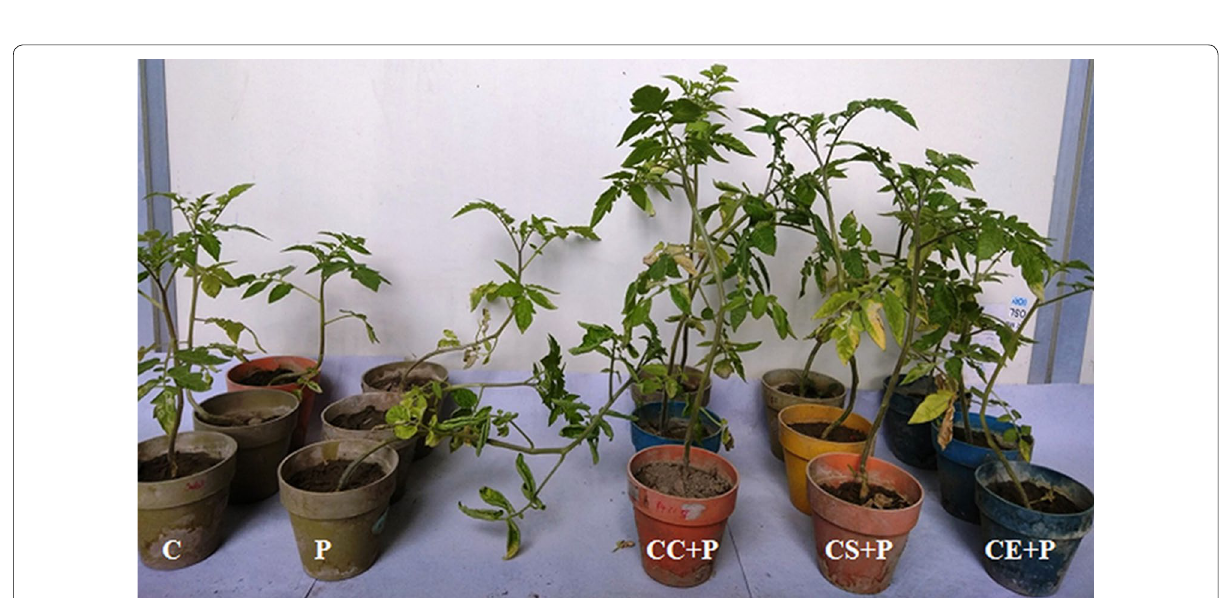
Fig. 7 Effect of Streptomyces sp. MR14 and its metabolites on growth of S. lycopersicum (tomato) plants infested with F. moniliforme ; C, control (water only); P, pathogen only;